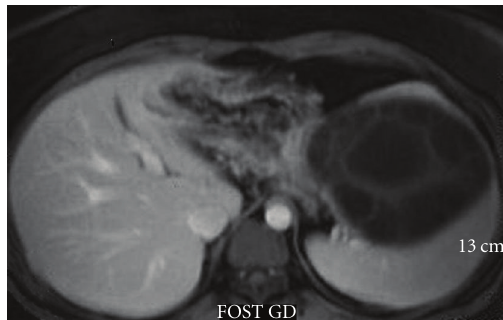
Figure 4: Axial contrast-enhanced T1-weighted MRI shows hypointense multivesicular splenic cyst showing no significant contrast enhancement, except some vague signal increase in the septal